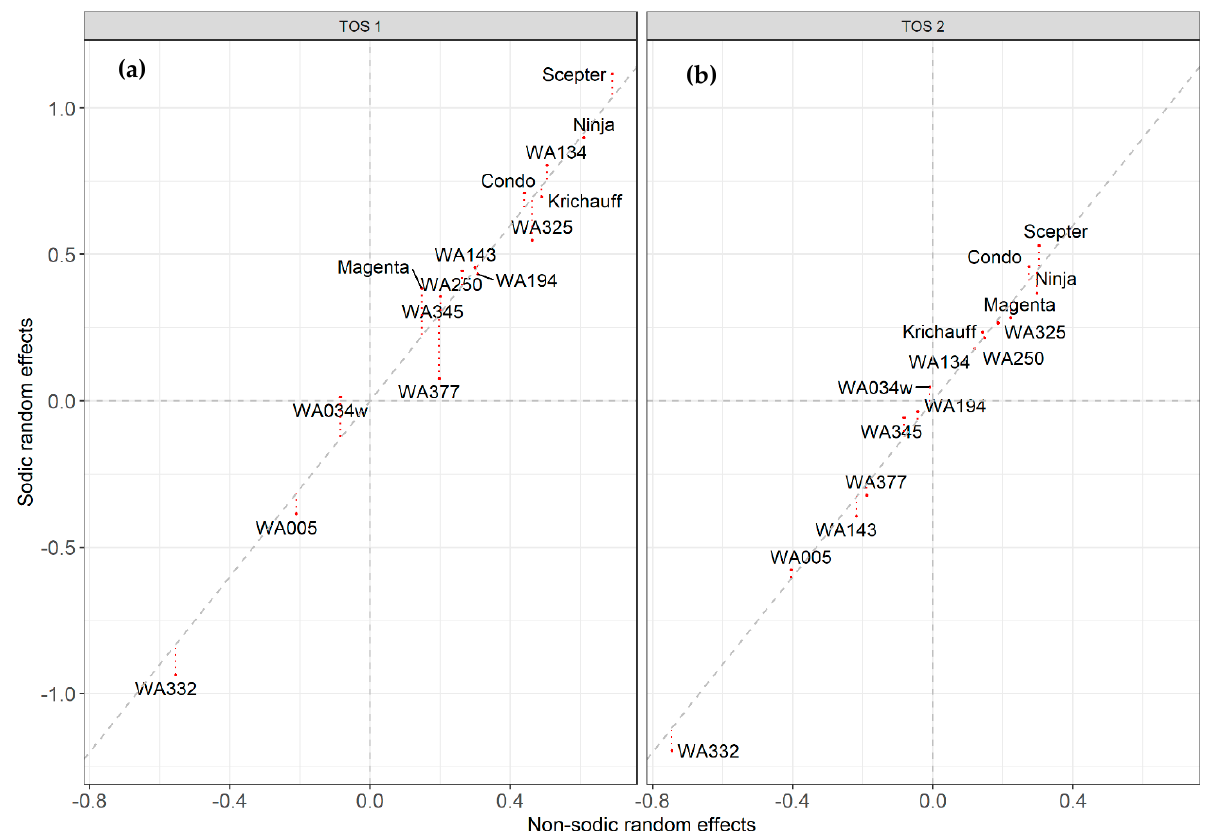
Figure 4. Plots of genetic effects from the sodic environment against genetic effects from the non-sodic environment in ( a ) TOS1 and ( b ) TOS2. Yield-ICT is the vertical distance between the point and the dashed regression line.